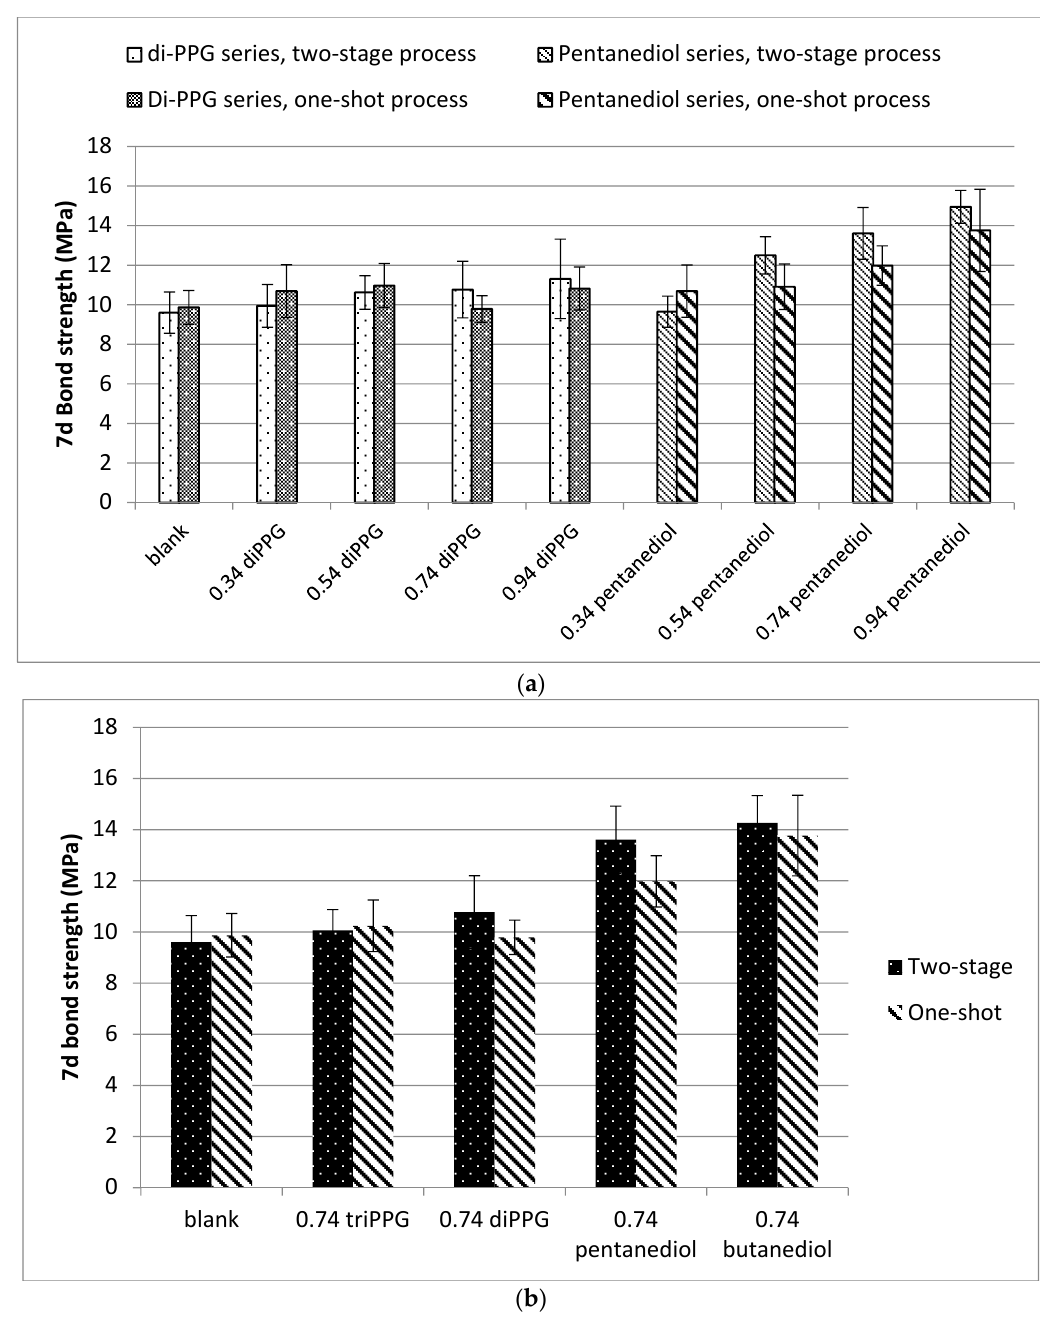
Figure 11. ( a ) The 7d bond strength of cured samples containing different amounts of di-PPG and pentanediol, prepared both by one-shot and two-stage process; ( b ) The 7d bond strength of cured samples with 0.74 molar ratio of different chain extenders, prepared in one-shot and two-stage processes.